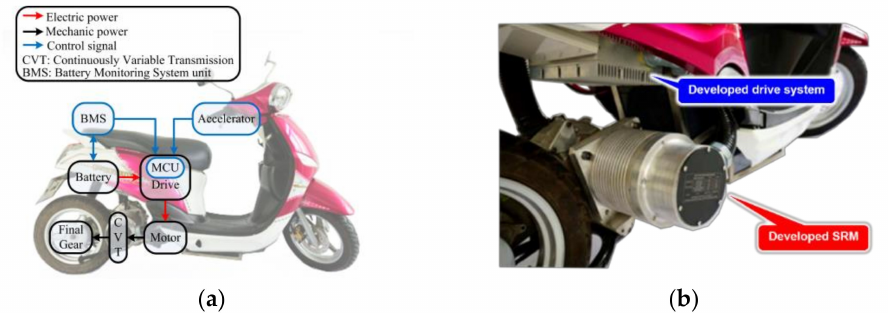
Figure 1. The electric motorcycle driven by the SRM and drive system. ( a ) The schematic of the electric motorcycle system; ( b ) the installed SRM and drive